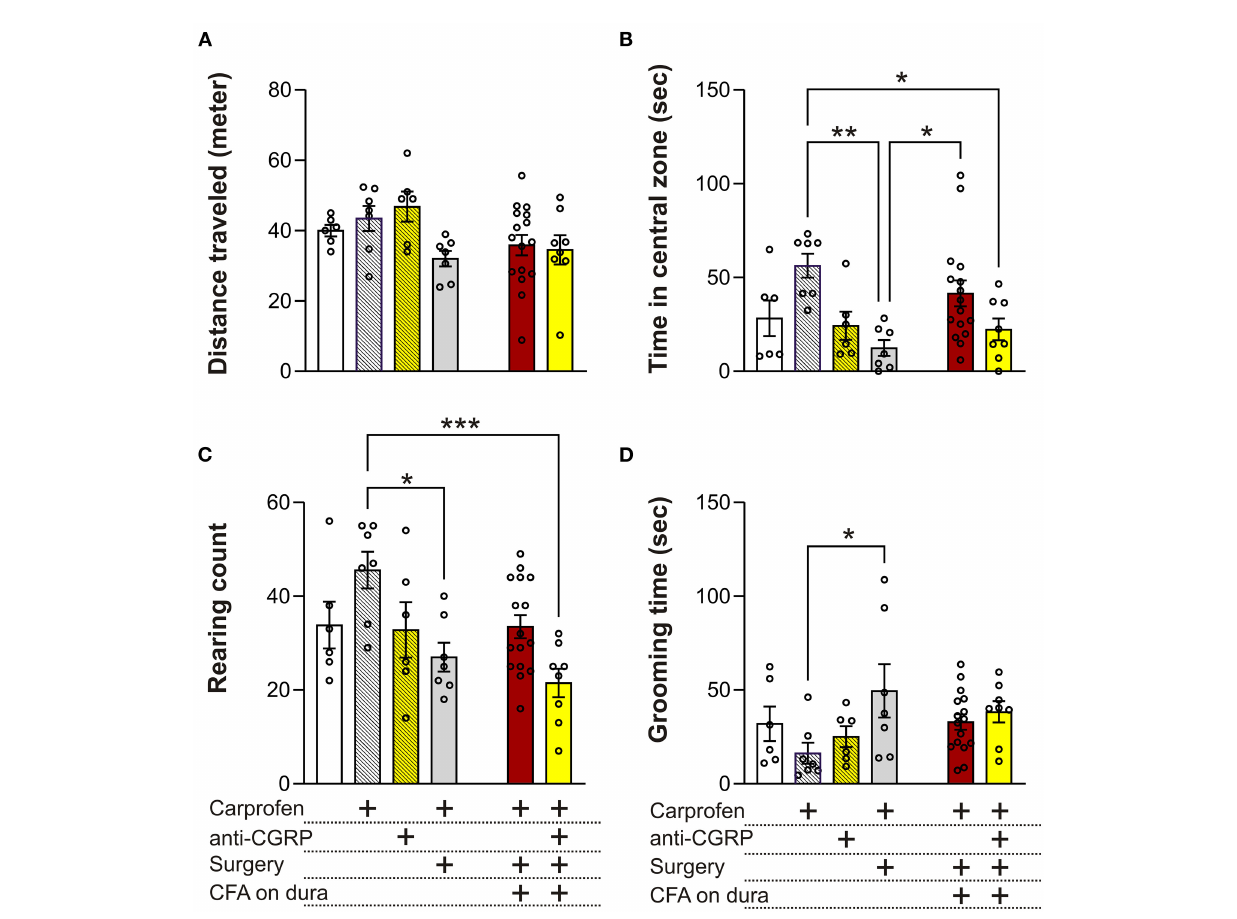
FIGURE4 Behavioral results from the OF test. (A) No significant differences on the distance traveled were observed between the groups. (B) No significant differences in time spent in central zone were observed between fresh + carprofen rats, fresh + anti-CGRP rats nor sham rats when compared with fresh rats. Sham rats spent significantly less time in the central zone than fresh + carprofen rats. No significant differences were observed in time spent in the central zone between fresh rats and fresh + carprofen when compared with CFA rats, but CFA rats spent significantly more time in the central zone than sham rats. No significant differences in time spent in the central zone were observed between CFA rats and fresh rats when compared with CFA + anti-CGRP rats. CFA + anti-CGRP rats spent significantly less time in the central zone than fresh + carprofen rats. No significant difference was observed between CFA + anti-CGRP rats and sham rats. (C) No significant difference in rearing count was observed between fresh + carprofen rats, fresh + anti-CGRP rats nor sham rats when compared with fresh rats. sham rats reared significantly less than fresh + carprofen rats. No significant differences in rearing count were observed between fresh rats, fresh + carprofen rats nor sham rats when compared with CFA rats. No significant differences in rearing count were observed between CFA rats nor fresh rats when compared with CFA + anti-CGRP